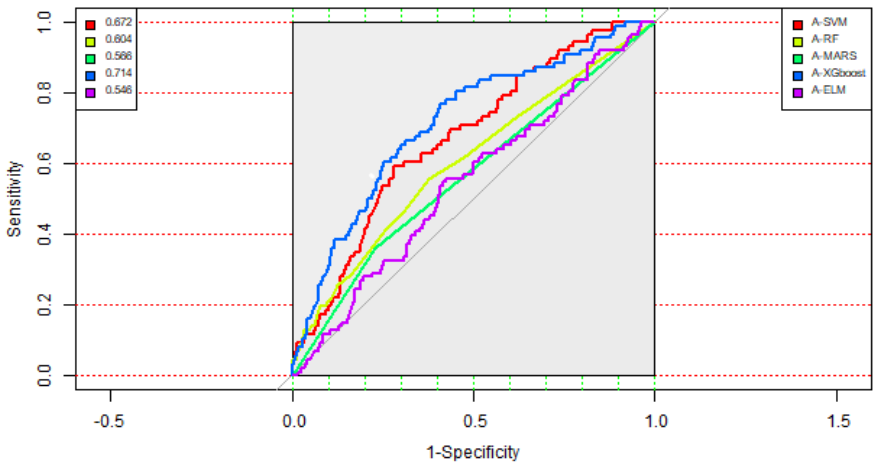
Figure 4. ROC curves of the five two-stage methods.